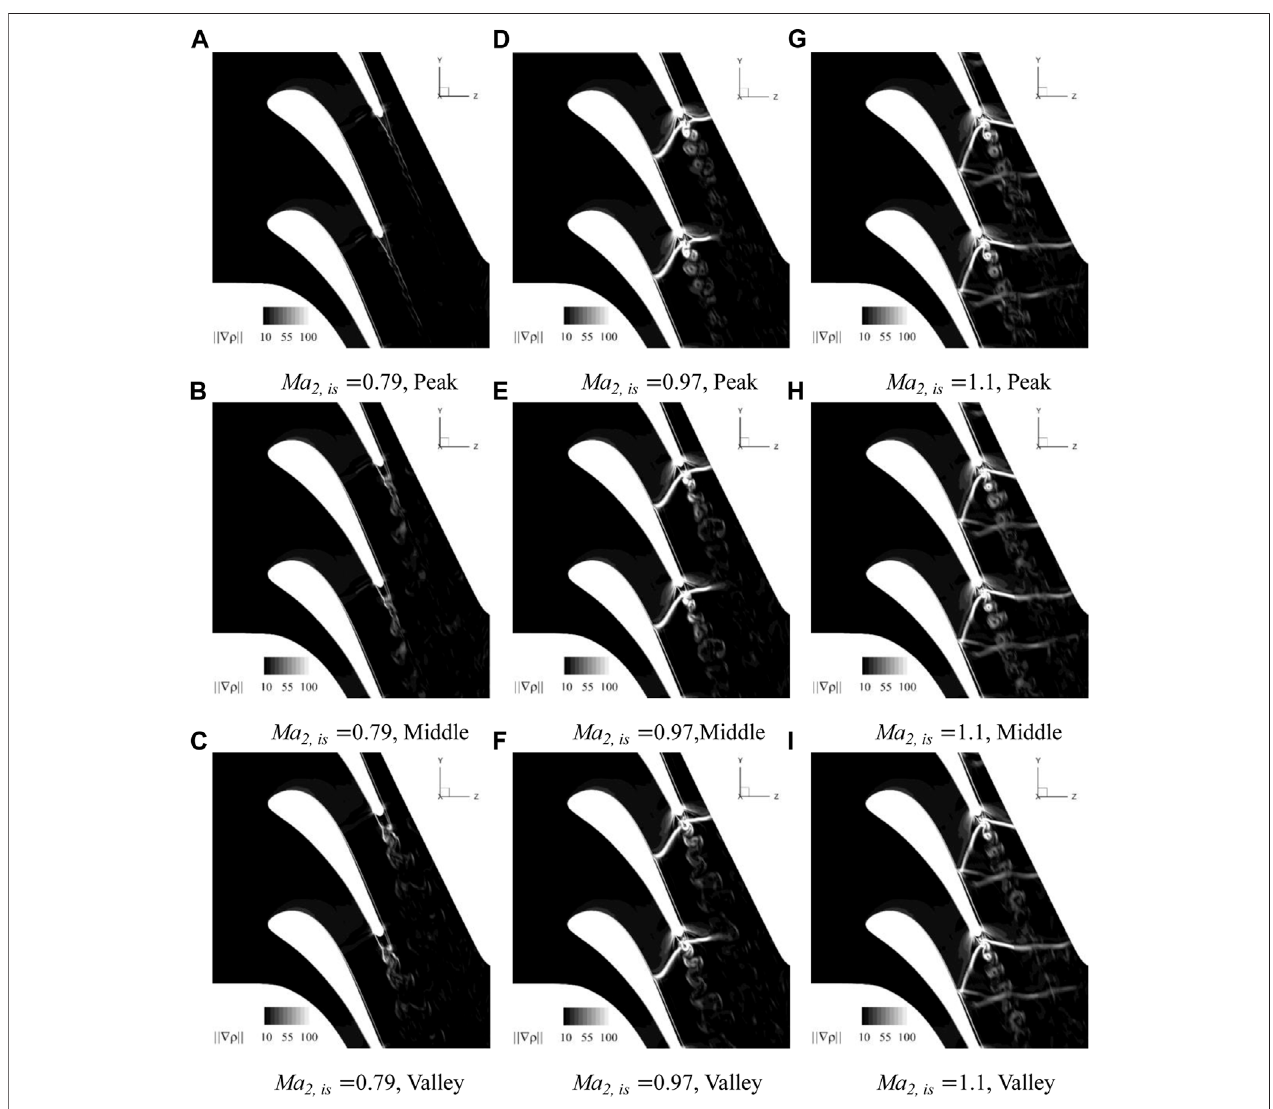
FIGURE 13 | Numerical Schlieren on peak, middle and valley sections at Ma 2 , is (cid:1) 0.79, 0.97, 1.1. (A) Ma2, is (cid:1) 0.79, Peak (B) Ma2, is (cid:1) 0.79, Middle (C) Ma2, is (cid:1) 0.79, Valley (D) Ma2, is (cid:1) 0.97, Peak (E) Ma2, is (cid:1) 0.97, Middle (F) Ma2, is (cid:1) 0.97, Valley (G) Ma2, is (cid:1) 1.1, Peak (H) Ma2, is (cid:1) 1.1, Middle (I) Ma2, is (cid:1) 1.1, Valley.